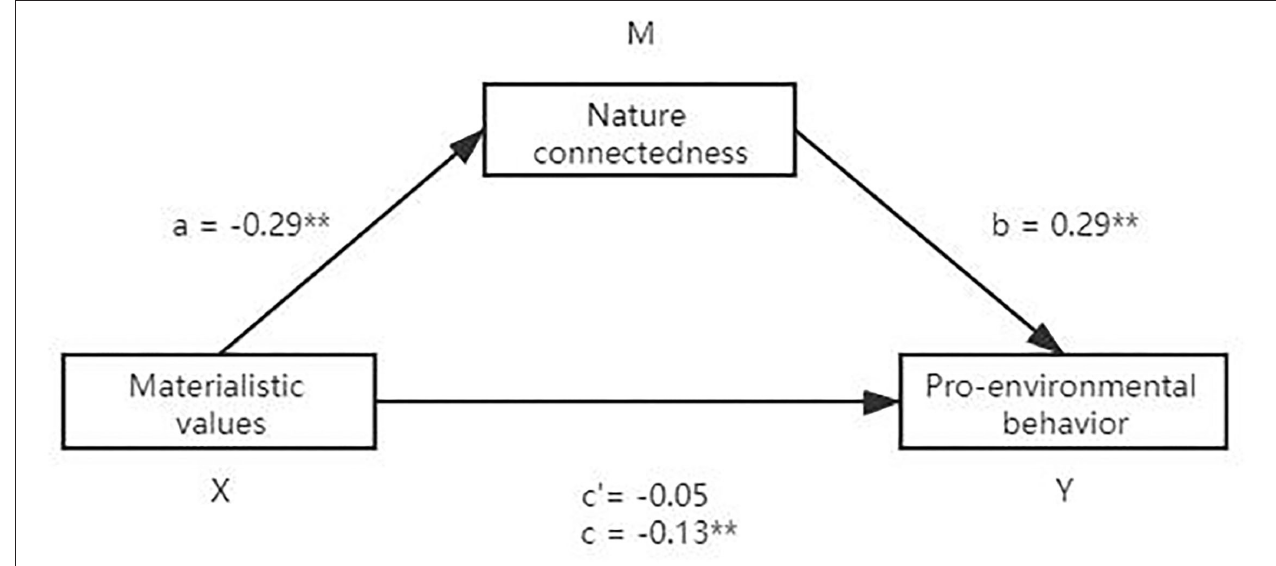
FIGURE 1 | Mediating effect of nature-connectedness on the relationship between materialistic values and pro-environmental behavior.